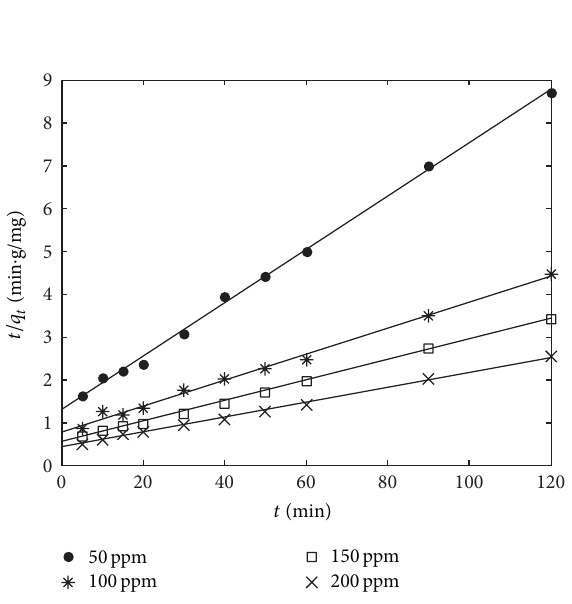
Figure 12: Biosorption kinetics for MB onto PTMF ( 𝑀 : 3 g; 𝑉 : 1L; pH: 6; agitation rpm: 150).